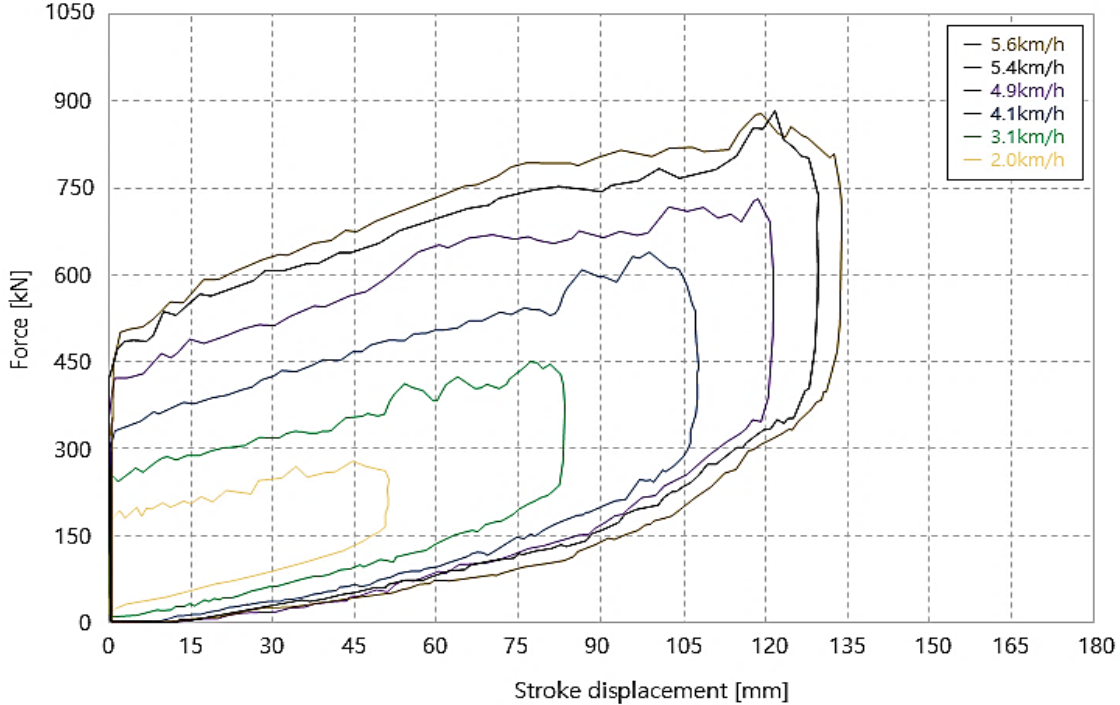
Figure 13. Characteristic curve of hydraulic buffer in collision test.